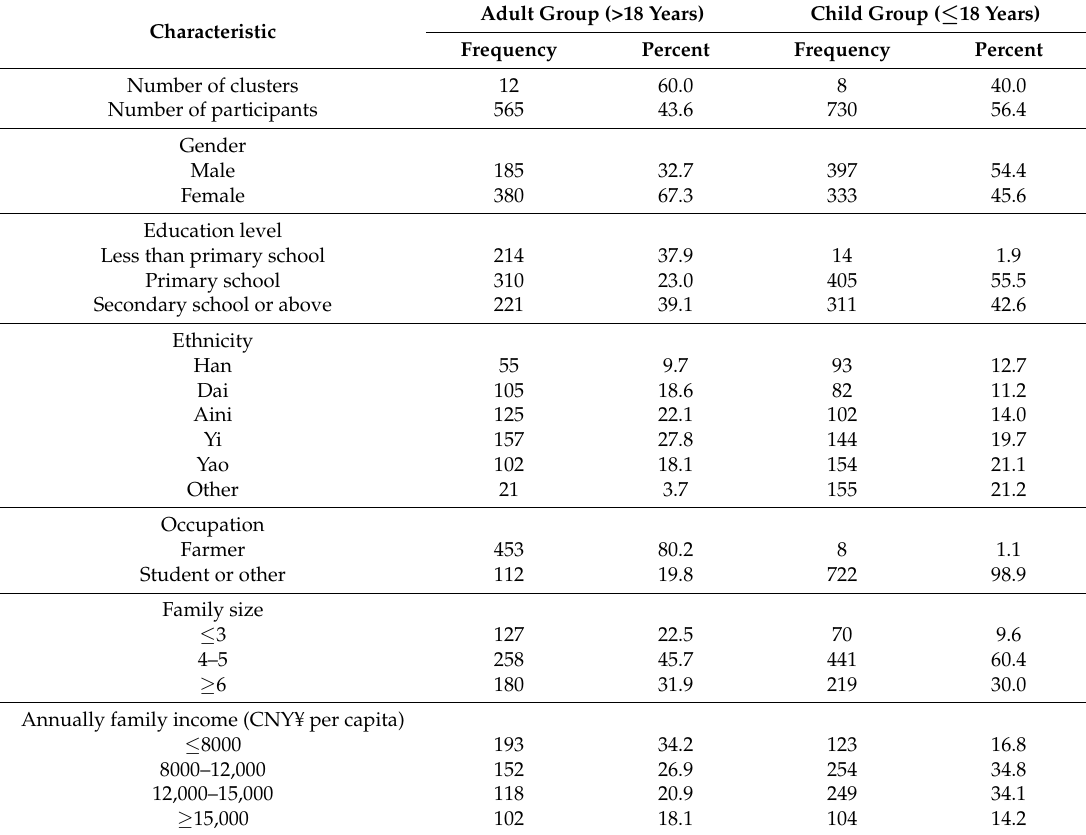
Table 1. Sociodemographic